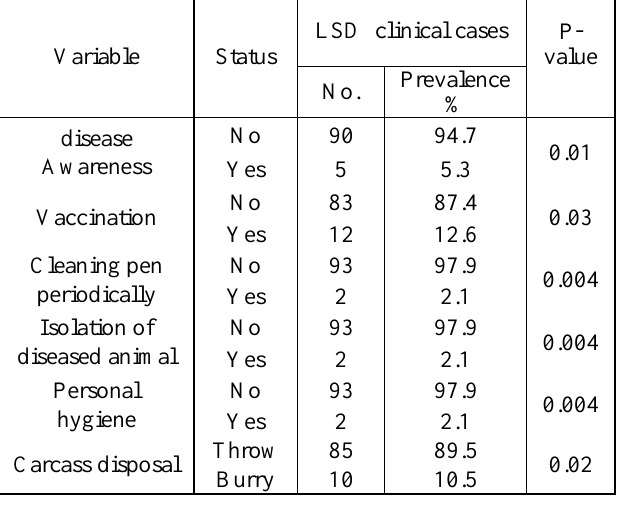
Table 4: Biosecurity procedures adopted in the infected farms with LSD in different